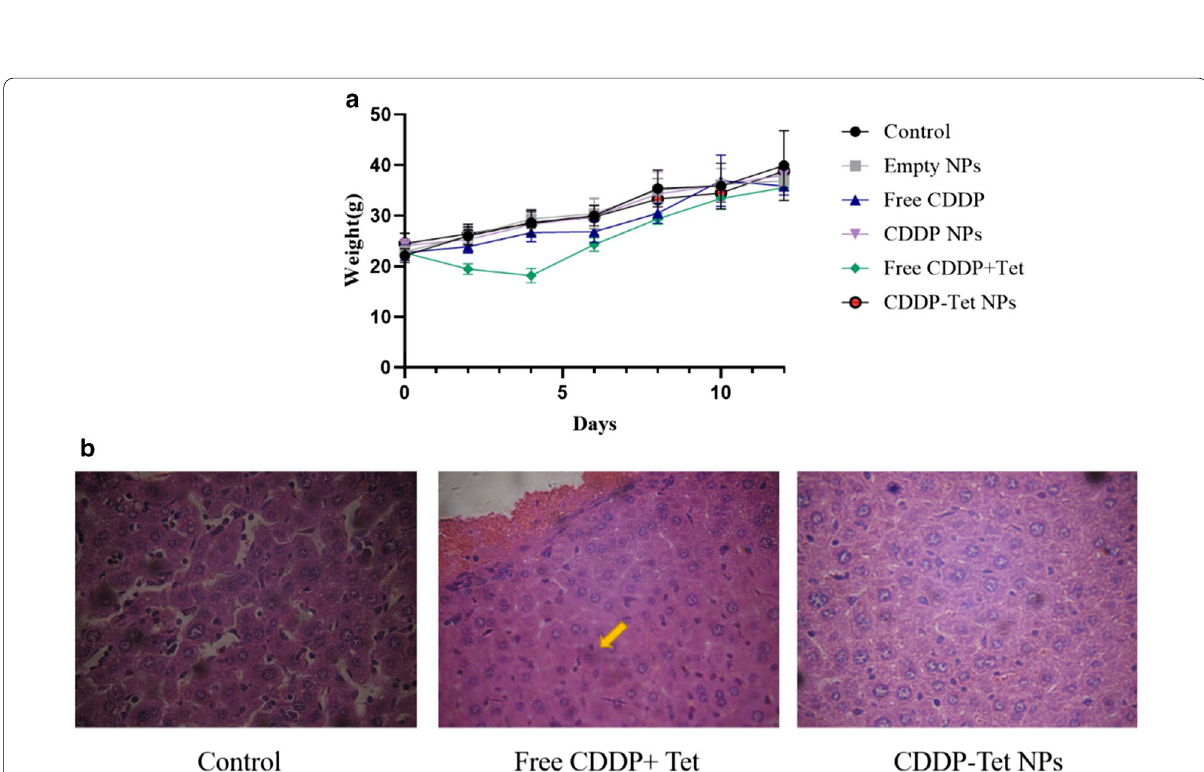
Fig. 8 Side effects evaluation a body weights of established H 22 xenografts in ICR mice during therapy under different treatments. b Liver specimens stained HE were on light microscopic observation (400 ×